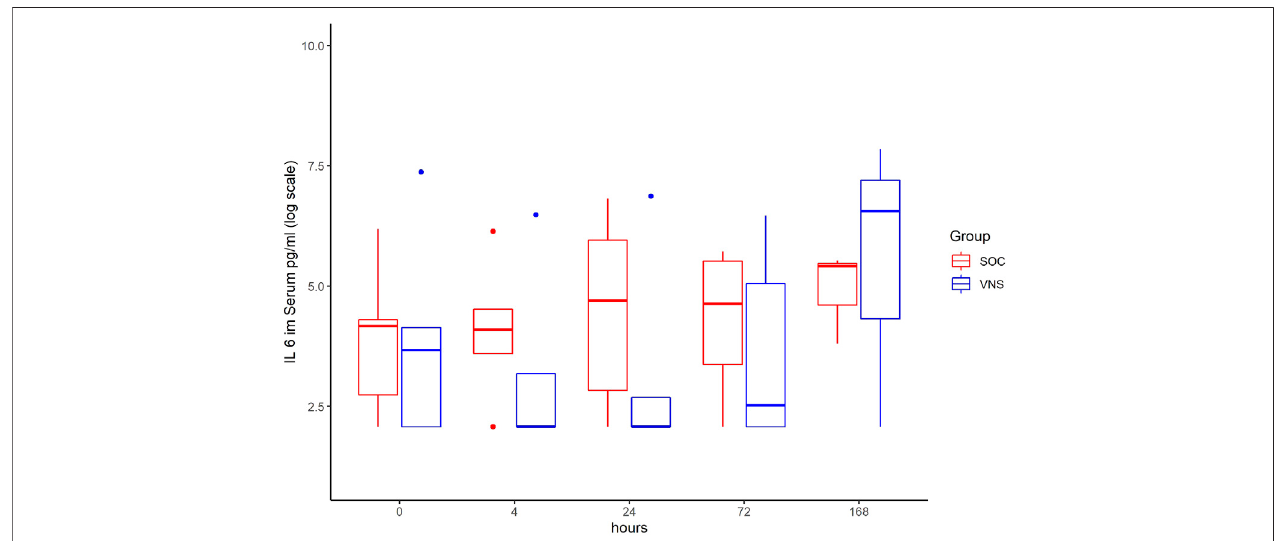
FIGURE 1 | Median IL-6 level with Interquartile Range of patients receiving auricular Vagus Stimulation (VNS = blue) and patients only receiving Standard of Care (SOC = red) after 0, 4, 24, 72, and 168 h of study inclusion.